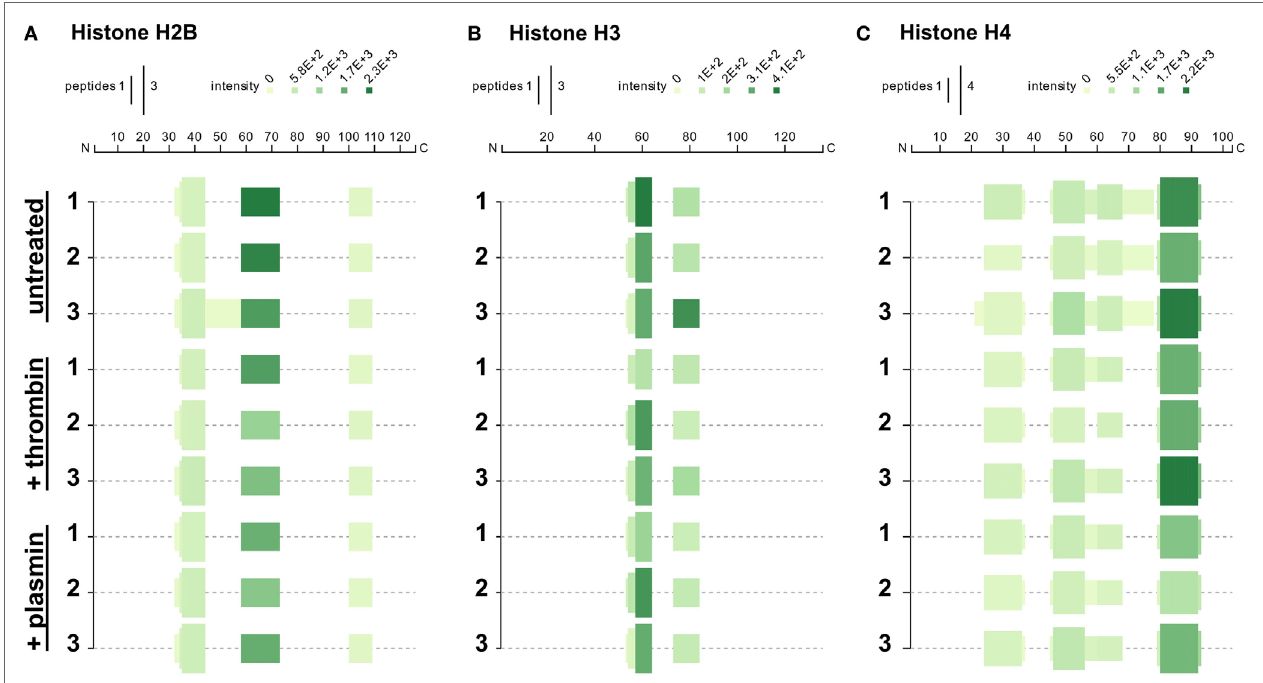
FigUre 5 | Peptigrams for histones H2B, H3.3, and H4. Peptigrams were generated using the sum of the respective peptide scores corresponding to (a) histone H2B subtype F (Q5QNW6), (B) histone H3 (Q5TEC6), and (c) histone H4 (P62805).